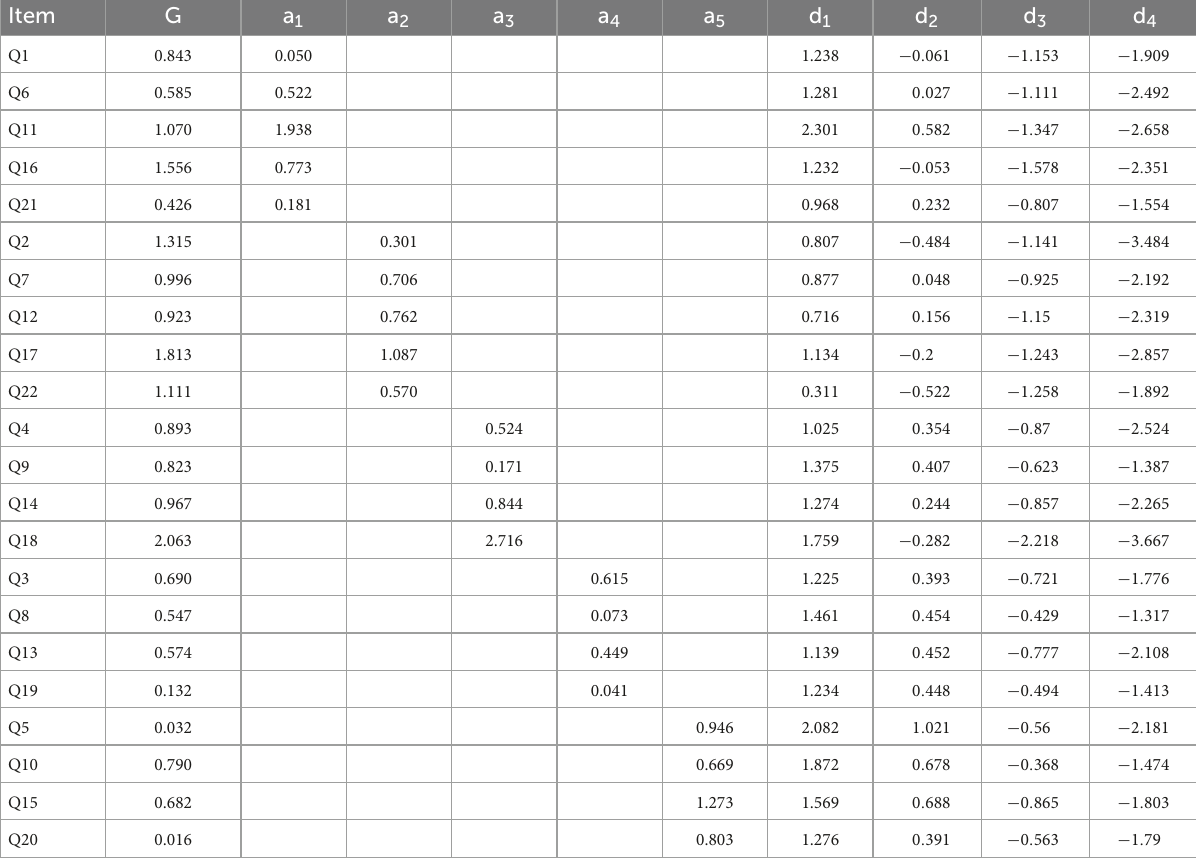
TABLE 3 Discrimination and threshold parameters for the bifactor MIRT model.